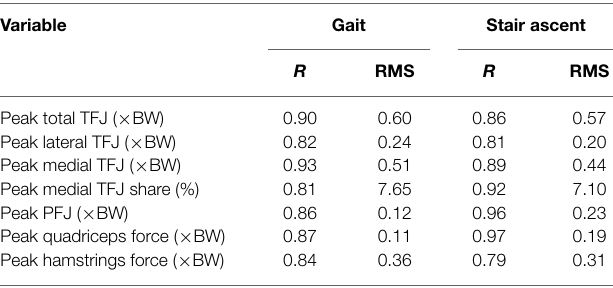
TABLE 2 | Within-subject agreement between waveforms for the three individual trials of both gait and stair ascent performed within test session 1 [figures presented are the across subject means, of the within-subject means of the correlation coefficients ( R ) and root mean square errors (RMS) for the comparison of trial 1 to trial 2, trial 1 to trial 3, and trial 2 to trial 3].